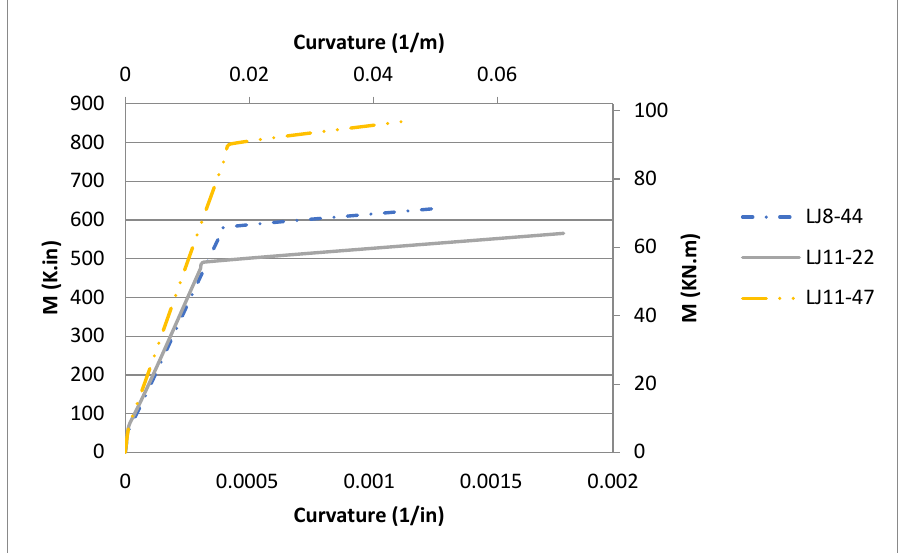
Figure 16. Ahmad and Batts (1991) [17] moment vs. curvature analytical graphs.